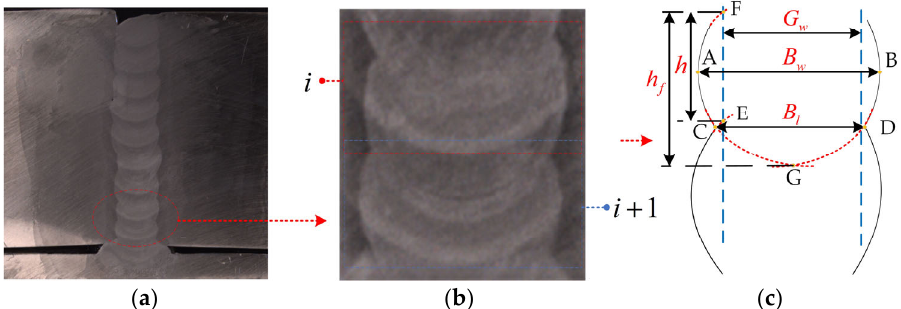
Figure 3. Illustration of weld image and geometric dimensions to be measured: ( a ) cross ‐ sectional image of a welded specimen; ( b ) a “measurement unit” image; ( c ) geometric dimension diagram.